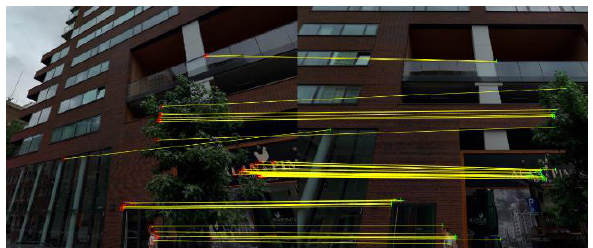
Figure 10. Vegetation and pedestrian are part of the registration result